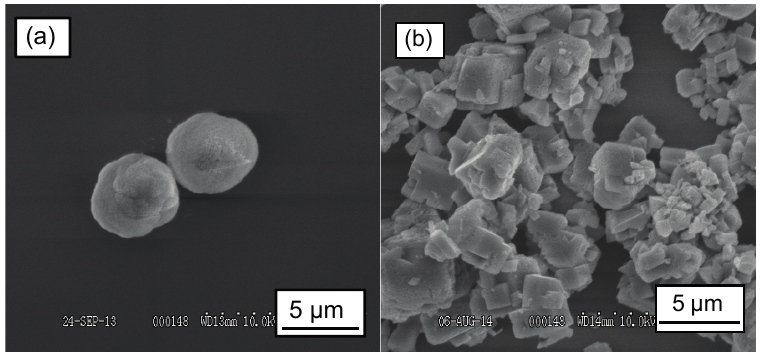
Figure 2. SEM images of insulin-containing CaCO the microspheres were immersed in buffer solution for insulin release.